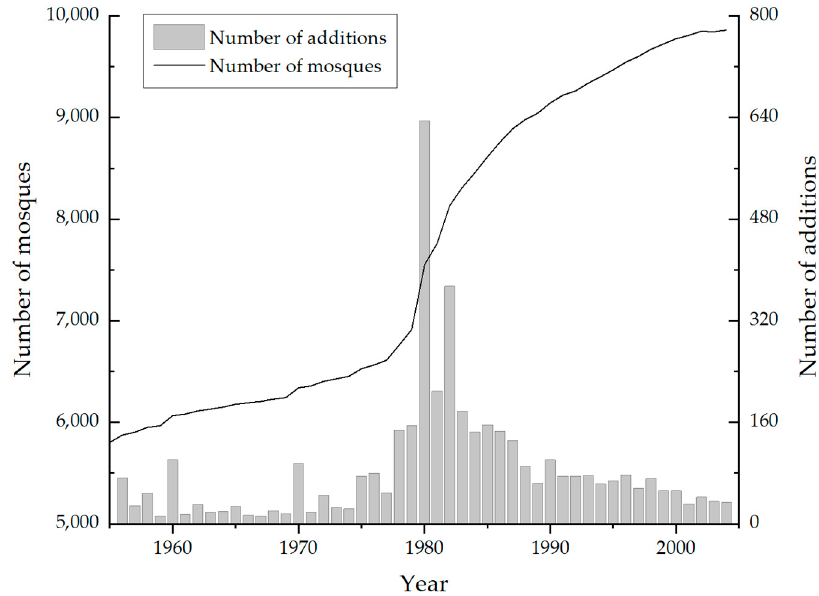
Figure 3. Trends in the number of mosques in the Kashgar region from 1955 to 2004.